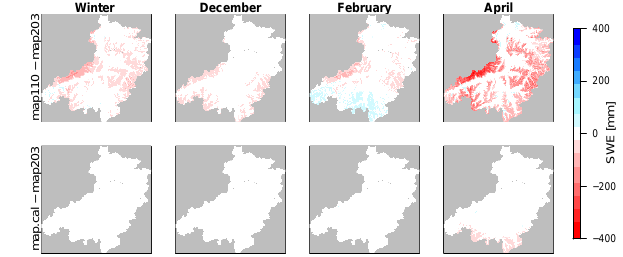
Fig. 8. Mean differences between map110–map203 (top) and map.cal–map203 (bottom) for the whole winter, and for December, February, and April (2001–2009) for the Alpine